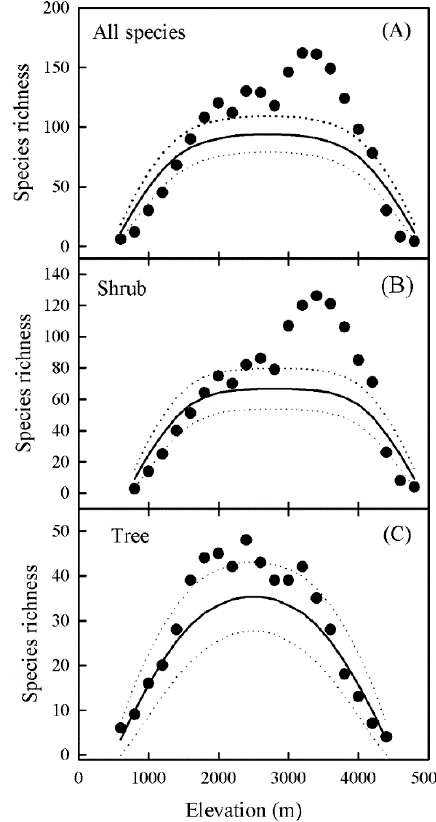
Figure 2. Elevational patterns of richness for all Ericaceae species ( A ), shrubs ( B ), and trees ( C ) in Yunnan, China. Solid dots and solid lines represent observed and predicted species richness, respectively. Dashed lines show 95% confidence intervals predicted by the mid-domain effect (MDE) randomization model.